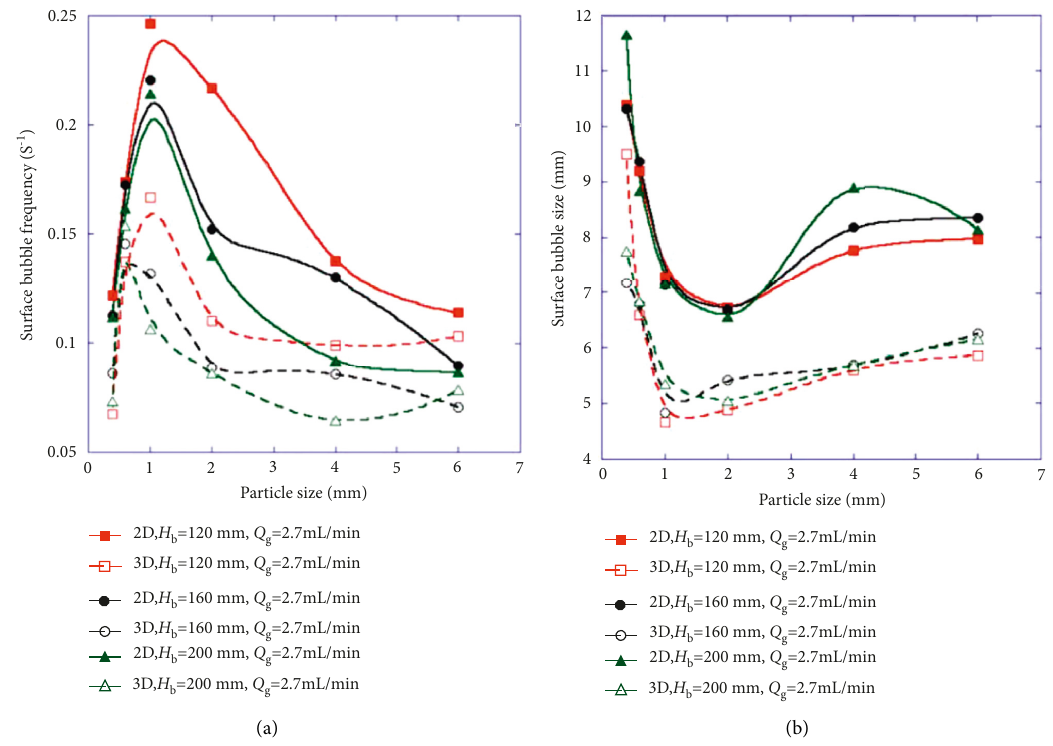
Figure 7: Effect of particle size on surface bubble frequency (glass particles) [31] (a) Surface bubble frequency (b) Surface bubble